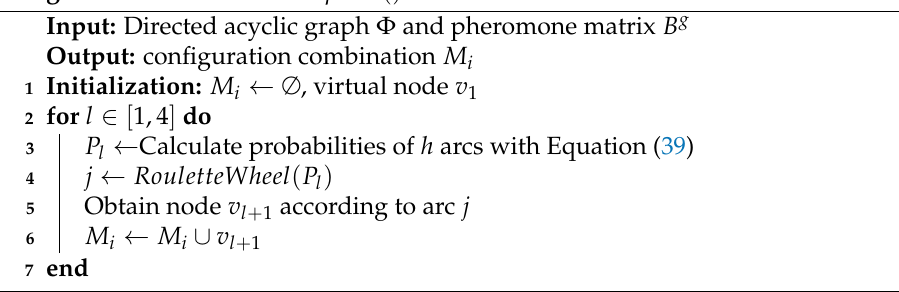
Algorithm 2: ParameterAdoption ()